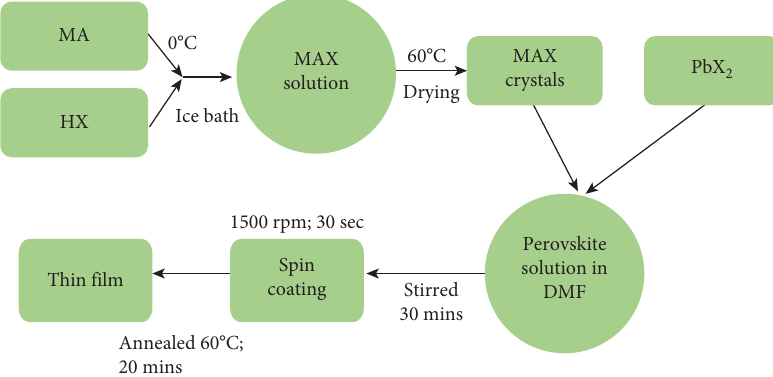
Figure 2: Flowchart of the experimental process.